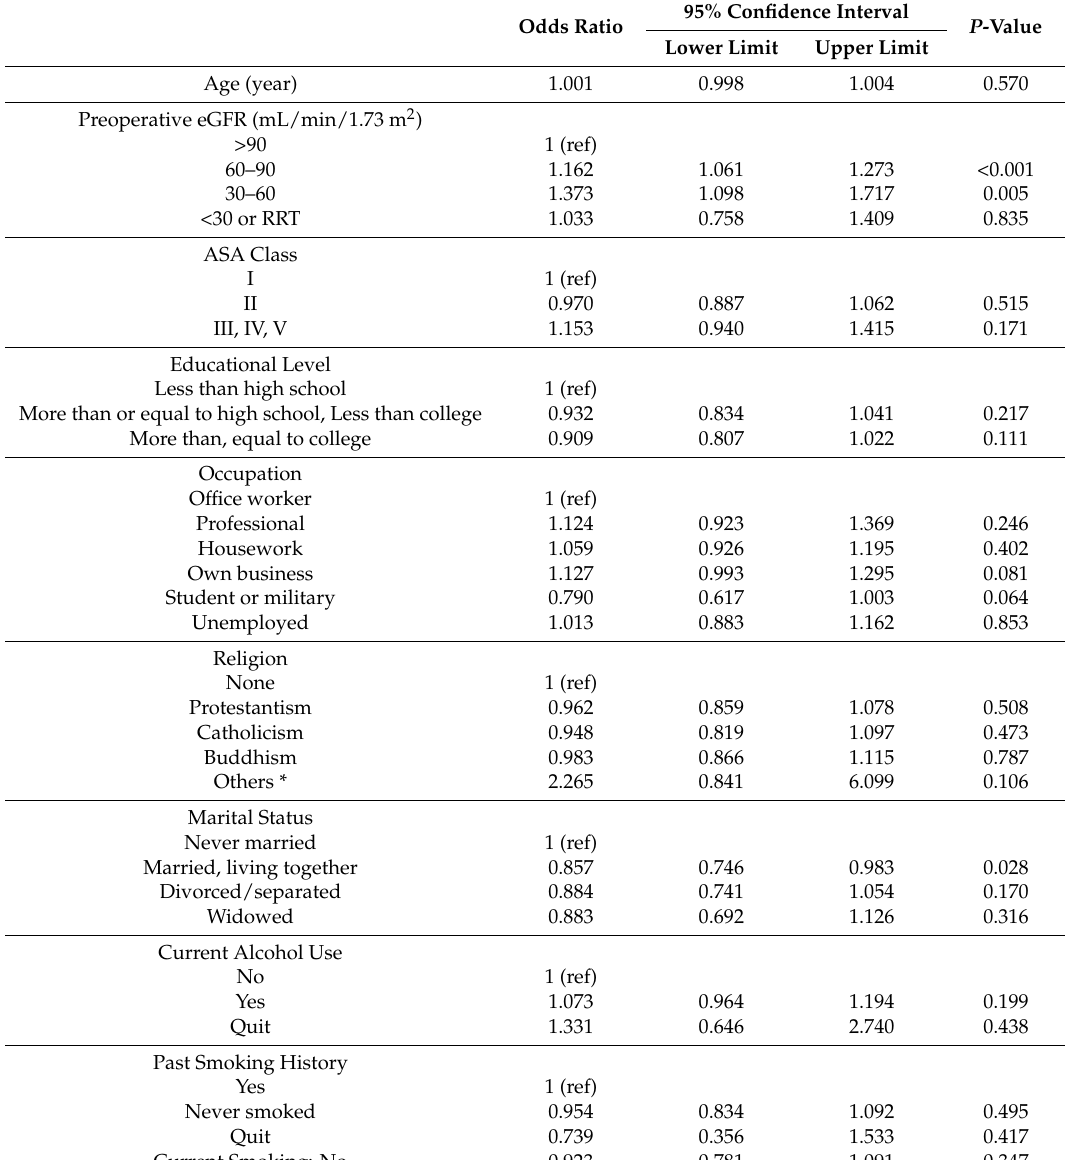
Table 3. Multivariate logistic regression analysis for all-cause one-year mortality after